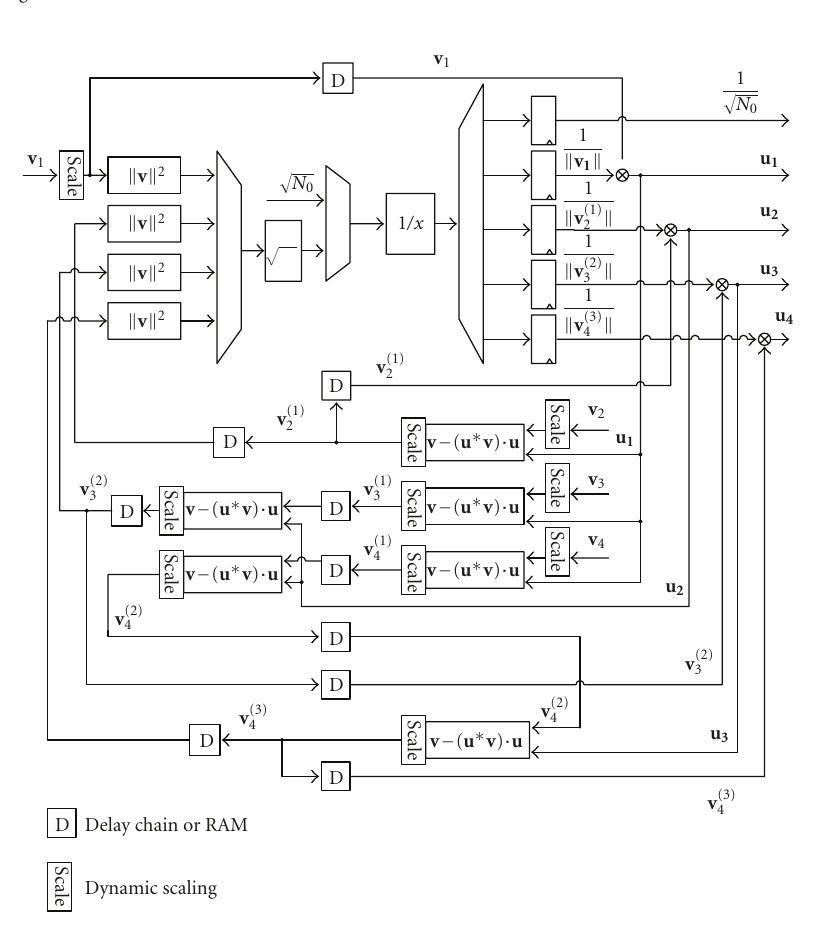
Figure 7: QR decomposition